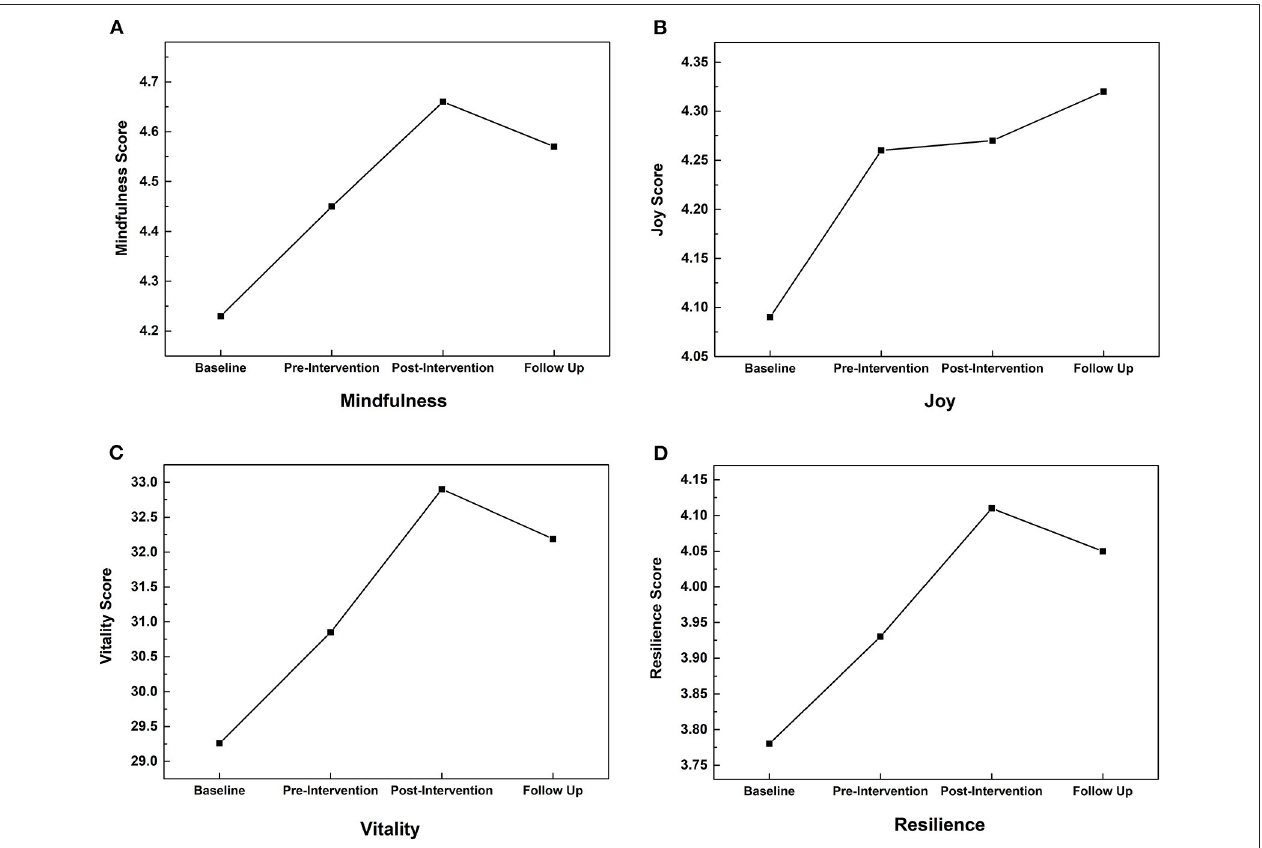
FIGURE 4 | Improvements in mindfulness, joy, vitality, and resilience with Samyama: change in scores across assessment timepoints for current state of (A) mindfulness (State Mindful Attention Awareness Scale), (B) joy (Joy Subscale of the Dispositional Positive Emotion Scale), (C) vitality (Subjective Vitality Scale), and (D) resilience (The Brief Resilience Scale).